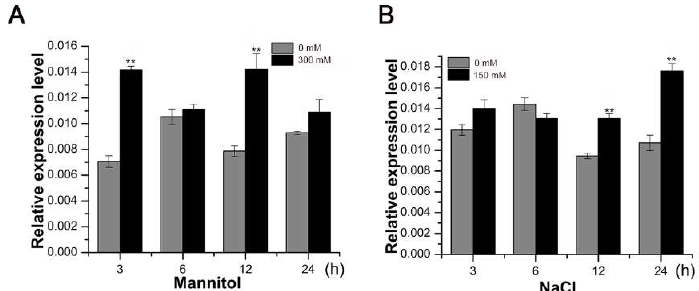
Figure 2. Expression profile of SsMAX2 of 4-week-old S. sebiferum seedlings in response to ( A ) osmotic and ( B ) salt stresses. 300 mM mannitol and 150 mM NaCl were applied to 20-day-old S. sebiferum seedlings. SsACT was used as the internal control. Data are presented as means ± SD of three biological replicates. Significant differences were determined by Student’s t -test. Significance level: ** p < 0.01.